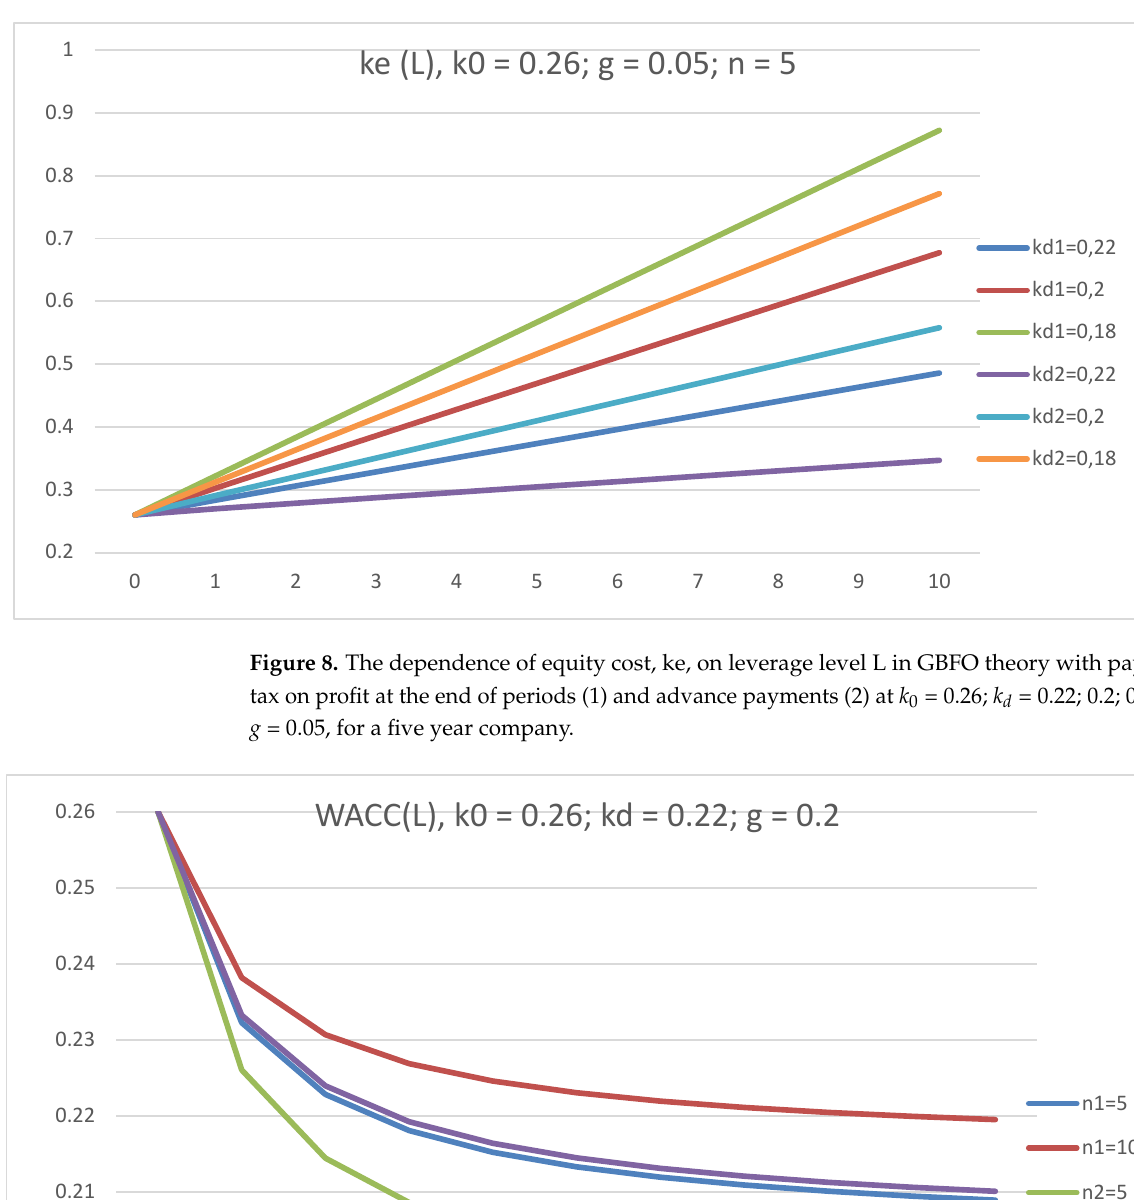
14 of 22 Figure 7. The dependence of company value, V, on leverage level, L, in GBFO theory with payments of tax on profit at the end of periods (1) and advance payments (2) at k 0 = 0.26; k d = 0.22; 0.2; 0.18; t = 0.2; g = 0.05, for a five-year company.